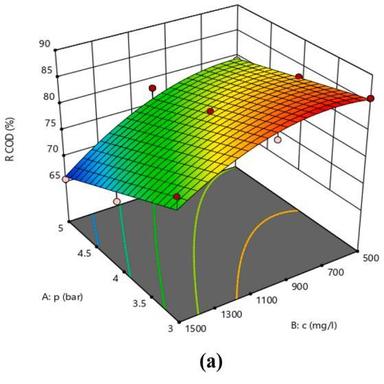
Plots of (a) 3D surface in dark condition; (b) 3D surface in light irradiation; (c) predicted vs. actual values for dye removal response.